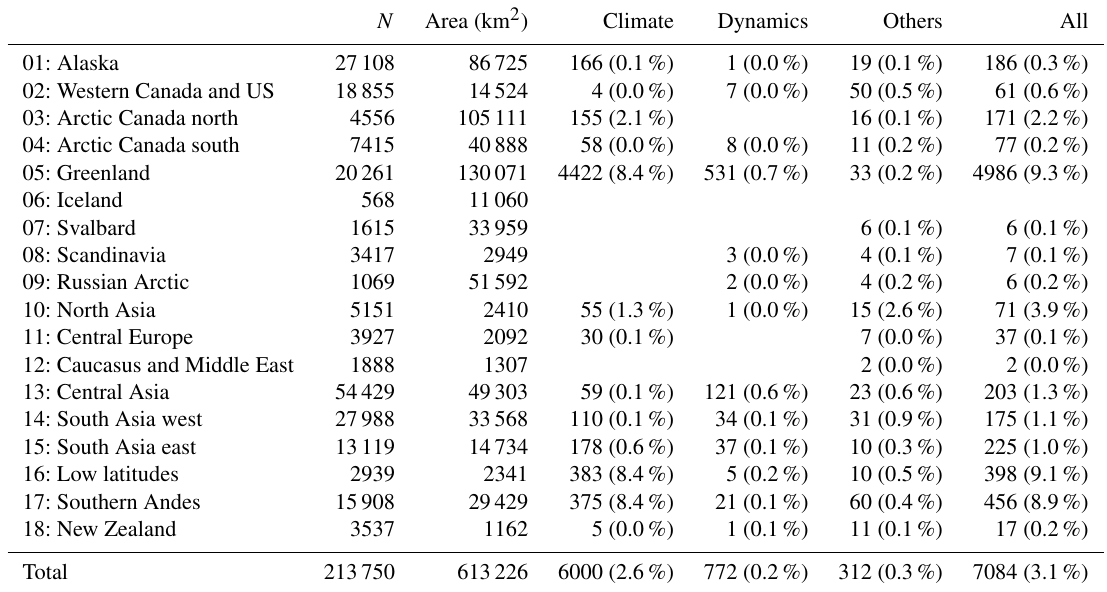
Table 1. Statistics of the model errors for each RGI region. The column names indicate which processing step produces an error, the value is the number of invalid glaciers and (in parentheses) the percentage of regional area they represent. N Area (km 2 ) Climate Dynamics Others